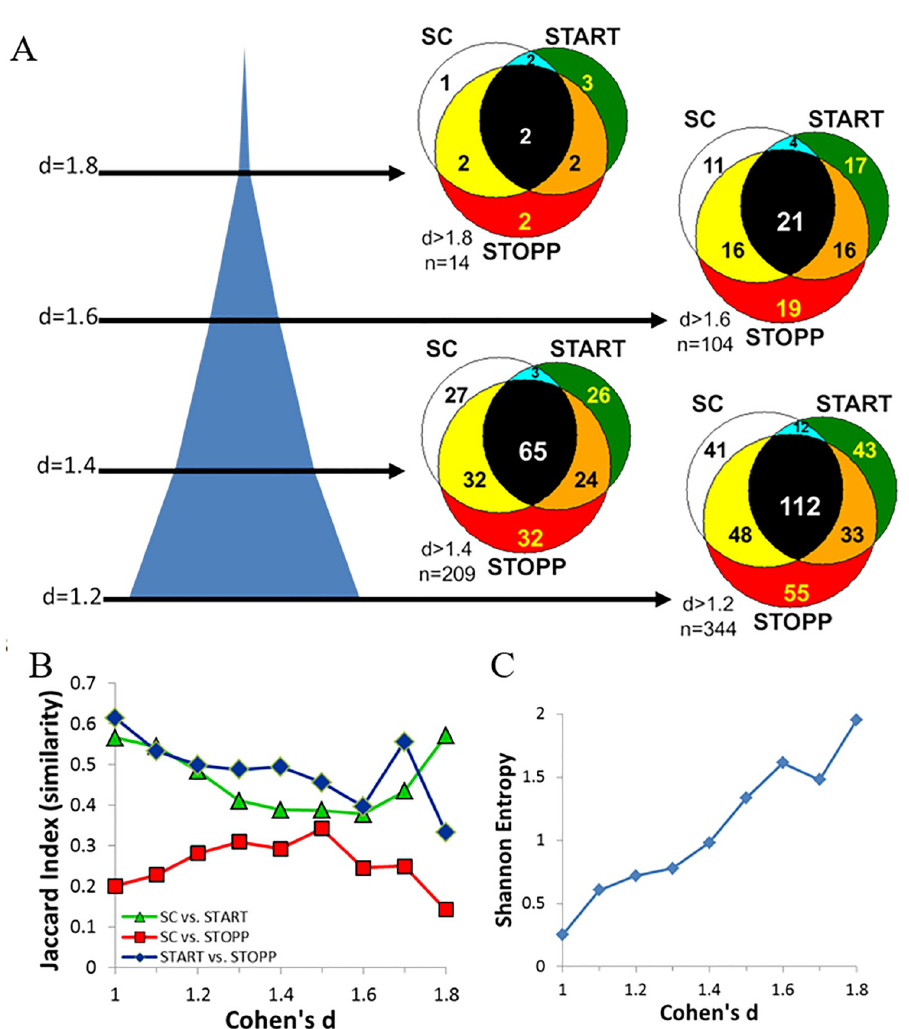
Fig 1. Selection of optimal Cohen’s d. (A) Cross-sections through the blue cone show the number of significant edges with FDR < 0.01 at different levels of Cohen’s d. The Venn diagrams show the numbers of edges in SC (white), START (green), STOPP (red), SC&START (aqua), SC&STOPP (yellow), START&STOPP (orange) and shared by all 3 groups (black) at each level of d. (B) Jaccard indices show the similarity of each pair of groups. Similarity was lowest at Cohen’s d = 1.6. (C) The disorder, or absence of overlap between groups, was confirmed by the peak in Shannon’s entropy at the same level.